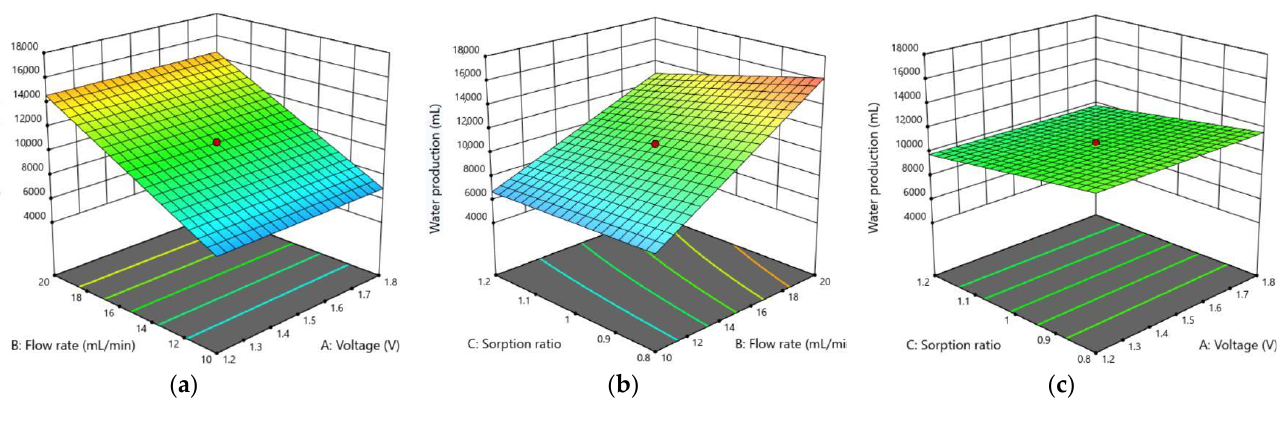
Table 8. ANOVA for the response surface 2FI model.